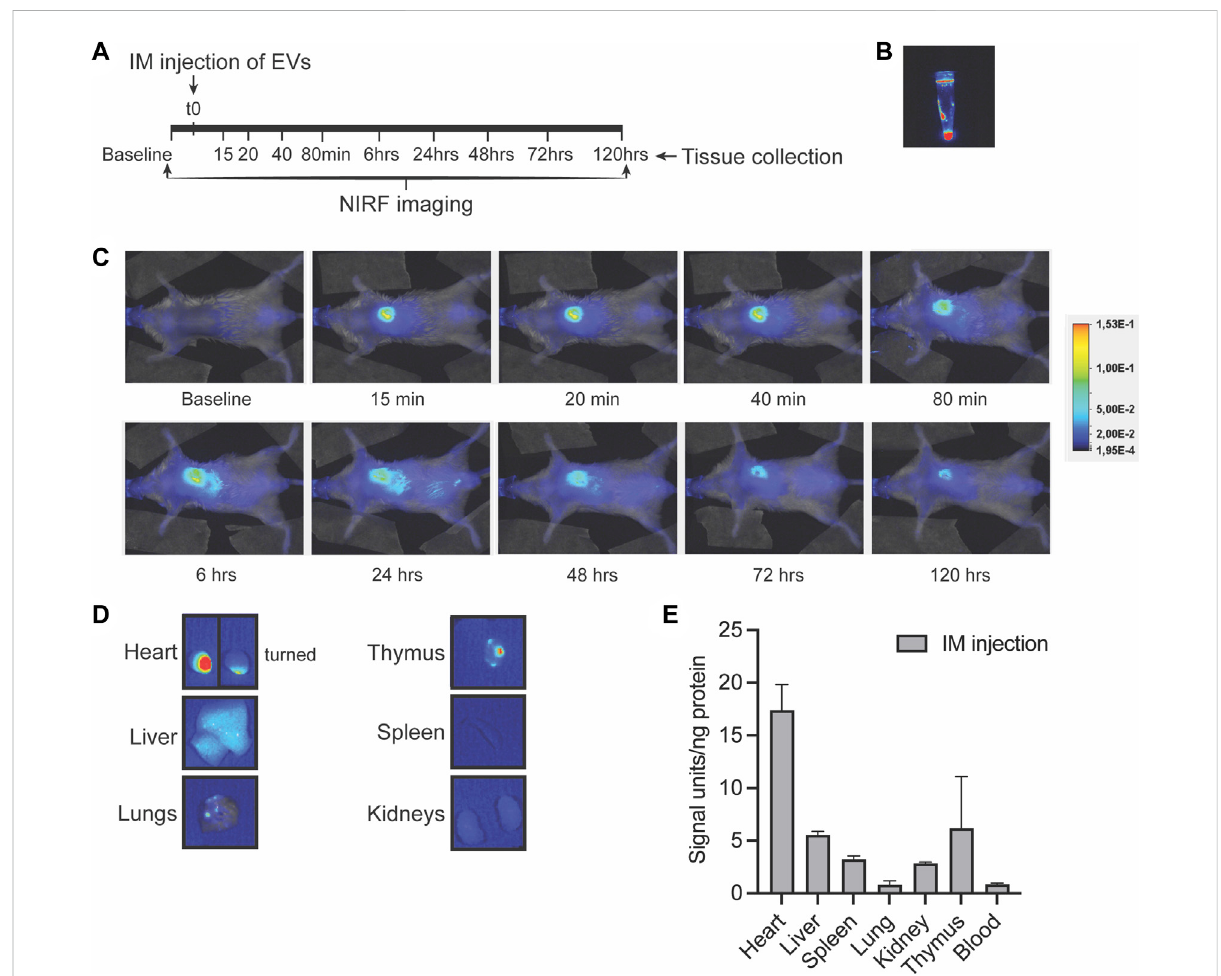
FIGURE 3 Long-term EV distribution in the mouse after intramyocardial injection. (A) Schematic overview of intramyocardial (IM) EV administration in the left ventricle wall and near-infrared (NIRF) imaging up to 5 days after intramyocardial injection. (B,C) Representative NIRF images taken from (B) the eppendorfcontaininglabeledEVs, (C) thelivinganimalatvarioustimepointsafterEVadministrationand (D) ofindividualorganscollectedafter5days follow-up. Uncut images are included in Supplementary Figure S11. (E) Quanti fi cation of fl uorescence (800nm) per ng protein in organ lysates as compared to organ background. Data of two mice are shown and are displayed as mean ±